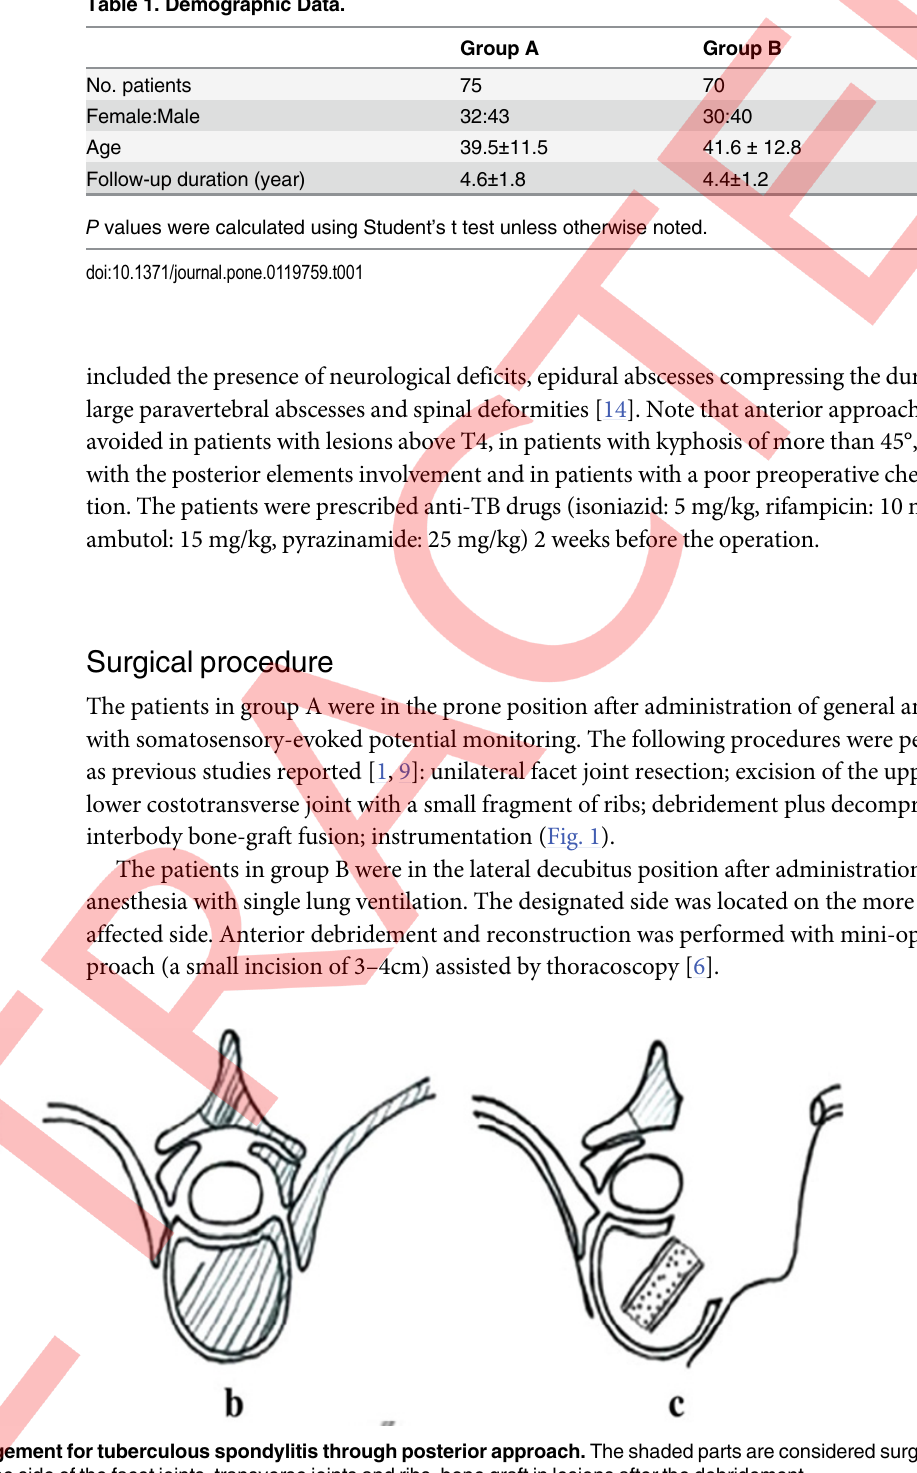
Table 1. Demographic Data.